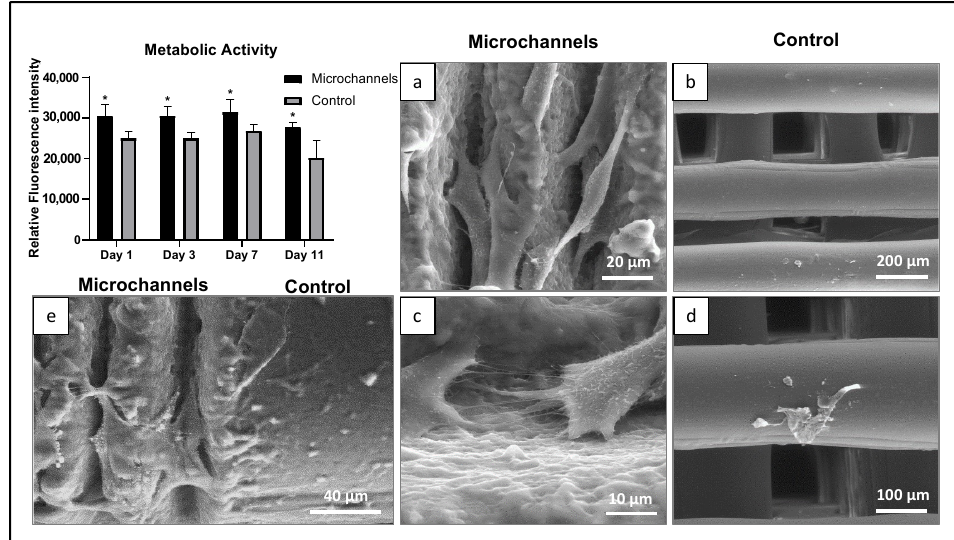
Figure 8. Metabolic activity (days 1, 3, 7, and 11) and SEM representative images (day 7) of human osteoblastic cells cultured over laser-induced microchannel topography on PCL ( a , c , e ) and control ( b , d , e ), in basal conditions. Scale bar: 20 μ m ( a ); 200 μ m ( b ); 10 μ m ( c ); 100 μ m ( d ), and 40 μ m ( e ). * Significant difference from control (unmodified PCL), p ≤ 0.05.